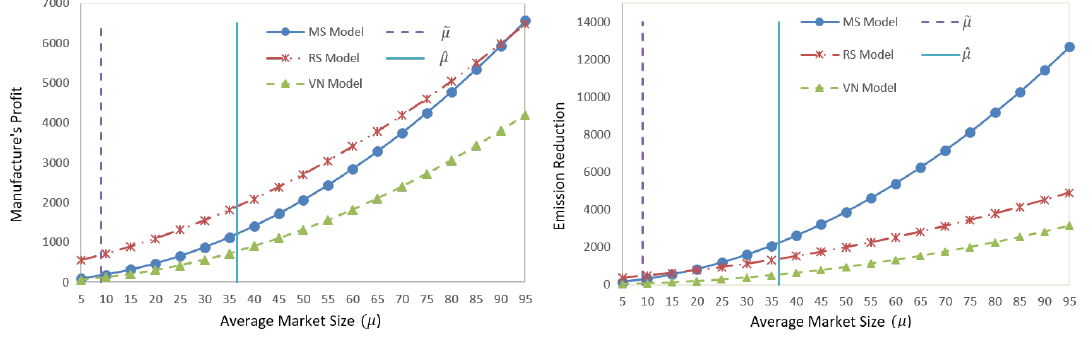
Figure 2. Impact of the average market size on the ( left ) manufacturer’s profits and ( right ) emission reduction in different power